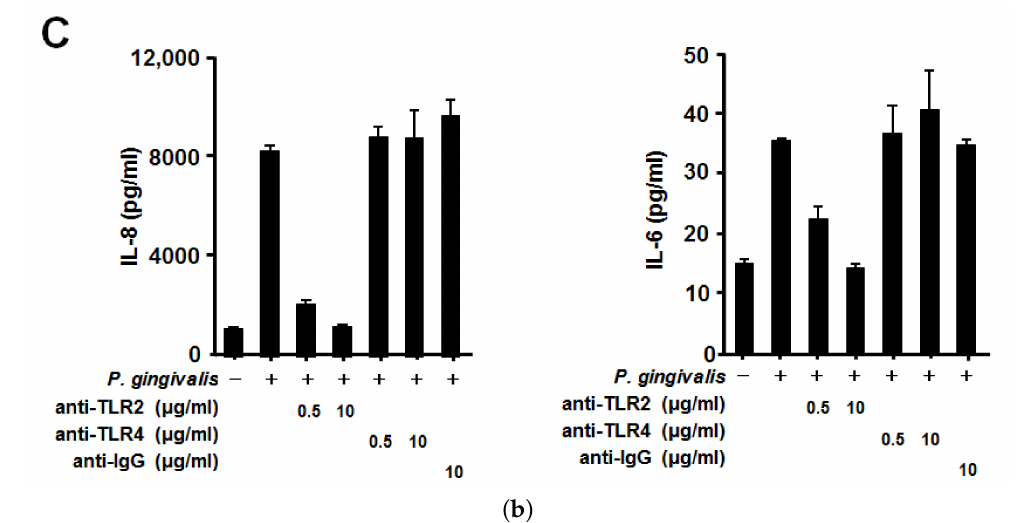
Figure 4. Involvement of Toll-like receptor (TLR)2 but not TLR4 in Porphyromonas gingivalis -induced proinflammatory cytokine production. ( A ) HEK293 cells, 293-TLR4 cells, or 293-TLR2 cells were transfected with a 5x κ B-luc reporter plasmid together with an internal pRL-TK control plasmid. Twenty-four hours after transfection, these cells were stimulated with heat-inactivated P. gingivalis (1 × 10 7 , 0.5 × 10 8 , or 1 × 10 8 CFU / mL), S. aureus LTA (5 µ g / mL), or E. coli LPS (200 ng / mL) for 24 h. Luciferase activity in the whole cell lysate was then determined. The data are presented as the fold increase in luciferase activity relative to that in control transfected cells (no stimulation). Data are presented as the mean ± SD of three independent transfections.BEAS-2B ( B ) and Detroit 562 ( C ) cells were pretreated with the indicated concentrations of anti-TLR2, anti-TLR4, or control antibodies for 1 h and then stimulated with or without P. gingivalis (1 × 10 8 CFU / mL). After 12 h incubation, culture supernatants were collected, and IL-8 and IL-6 levels were measured using enzyme-linked immunosorbent assay. These experiments were performed in triplicate, and data are presented as the mean ±